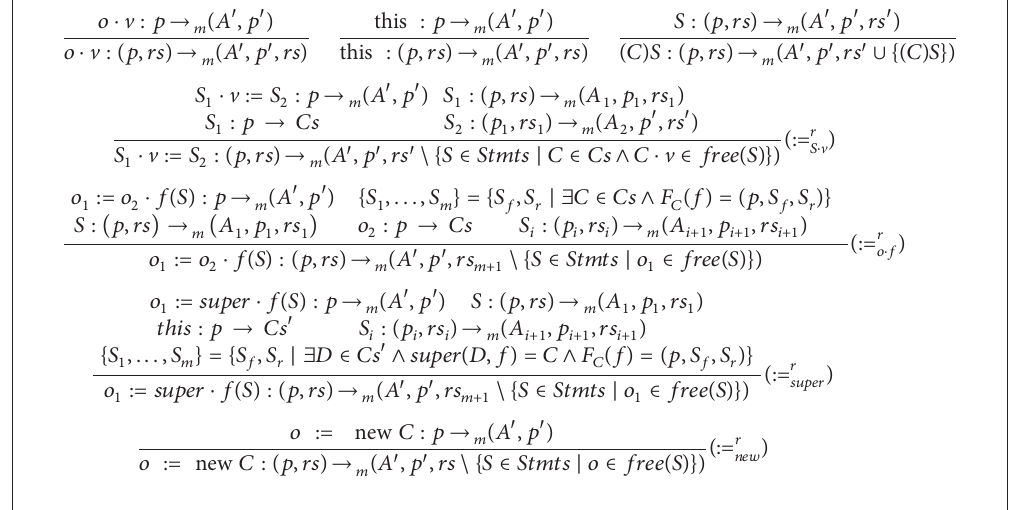
Algorithm 5: An extension for the ready type system to cover OODP programs.